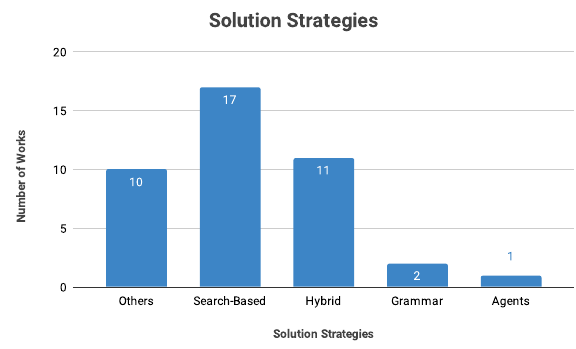
Figure 9. Number of works by solution